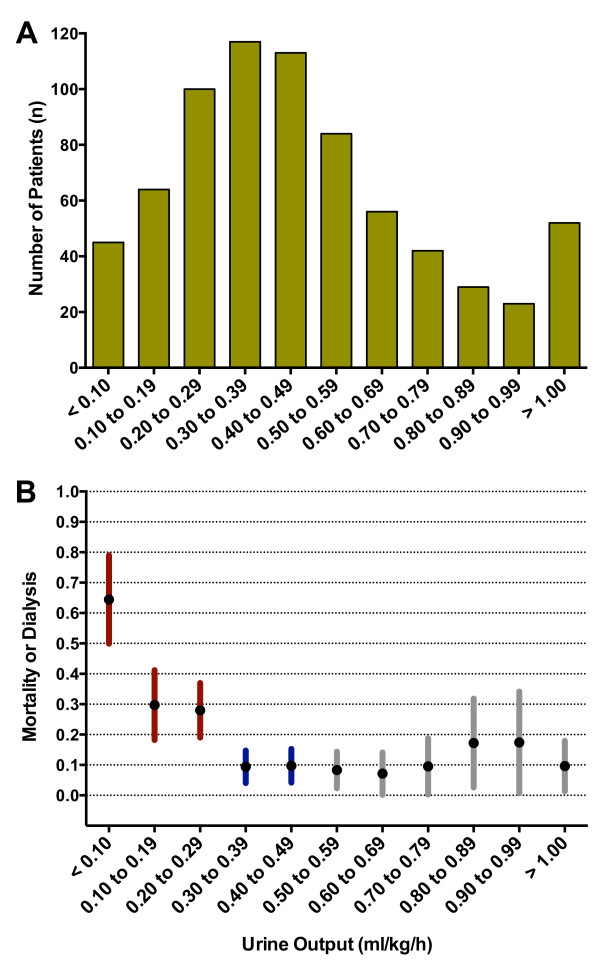
Mortality or dialysis according to 6-hour urine output groups. (A) Number in each group. (B) Proportion of mortality or dialysis in each group. Error bars represent 95% confidence intervals.